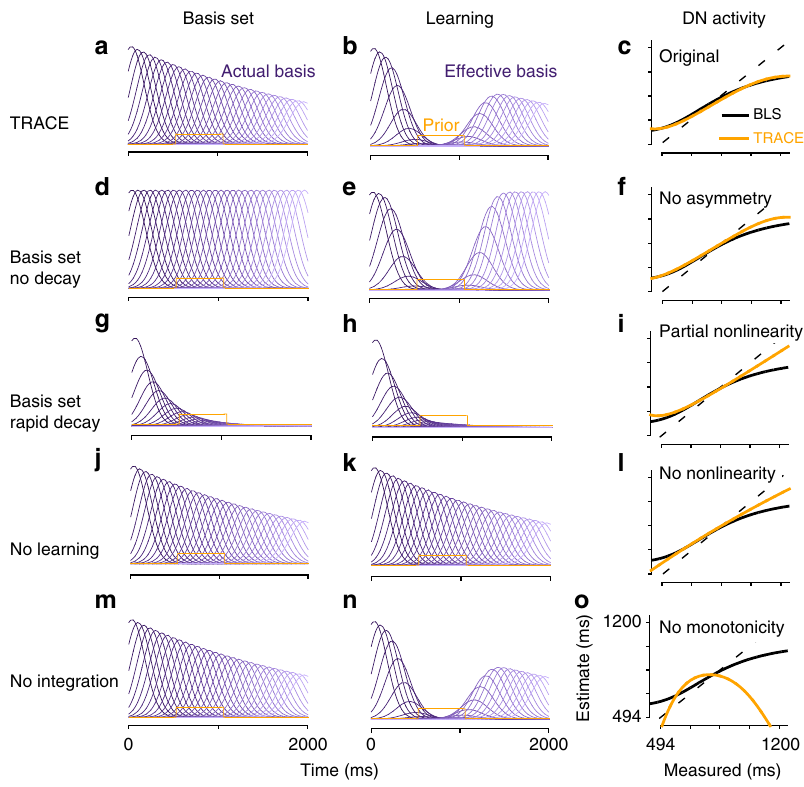
Fig. 7 TRACE in-silico lesions. a-c TRACE with all three model components intact. a The basis set. b The basis set weighted by modi fi ed GC to PC synapses after learning of the prior distribution has reached steady state. c The linearly transformed output of TRACE (orange) superimposed on the BLS function (black). d – f Same format as for a – c when there is no decay in the basis set. The asymmetry in TRACE output is lost. g – i Same as earlier panels with rapid decay of basis set. The nonlinear bias for longer intervals is abolished. j – l If no learning takes place, then there is no nonlinearity in the model output. m – o If no integration takes place, there is no monotonically increasing output, leading to signi fi cant deterioration in